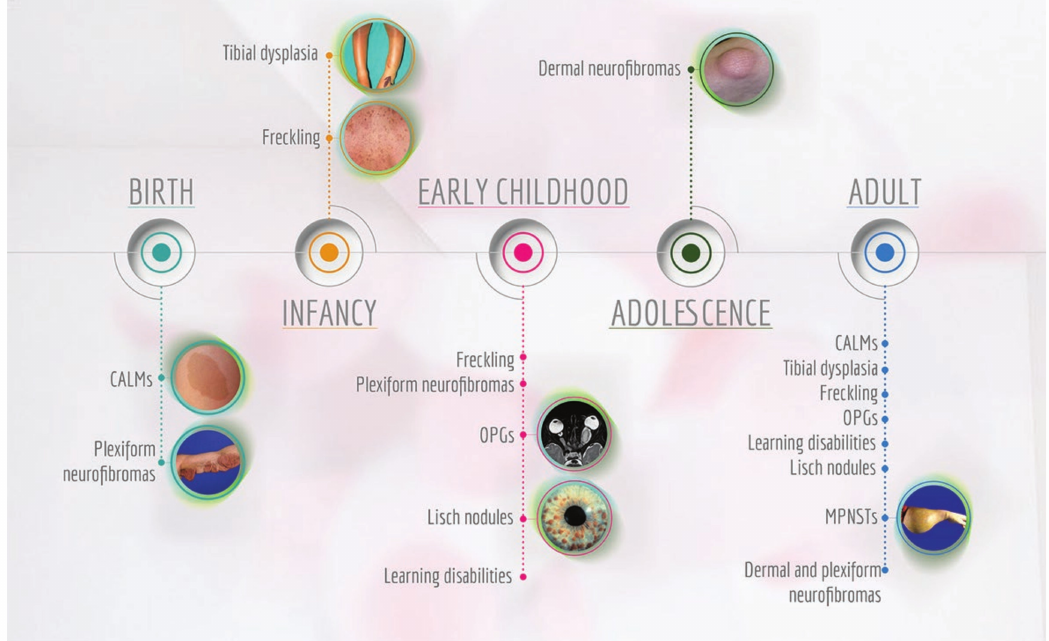
Figure 4. Main NF1 clinical manifestations arranged according to their corresponding age of onset. CALMs: caf é au lait macules; MPNSTs: malignant peripheral nerve sheath tumours; OPGs: optic pathway gliomas. Figure was redrawn from Williams et al.